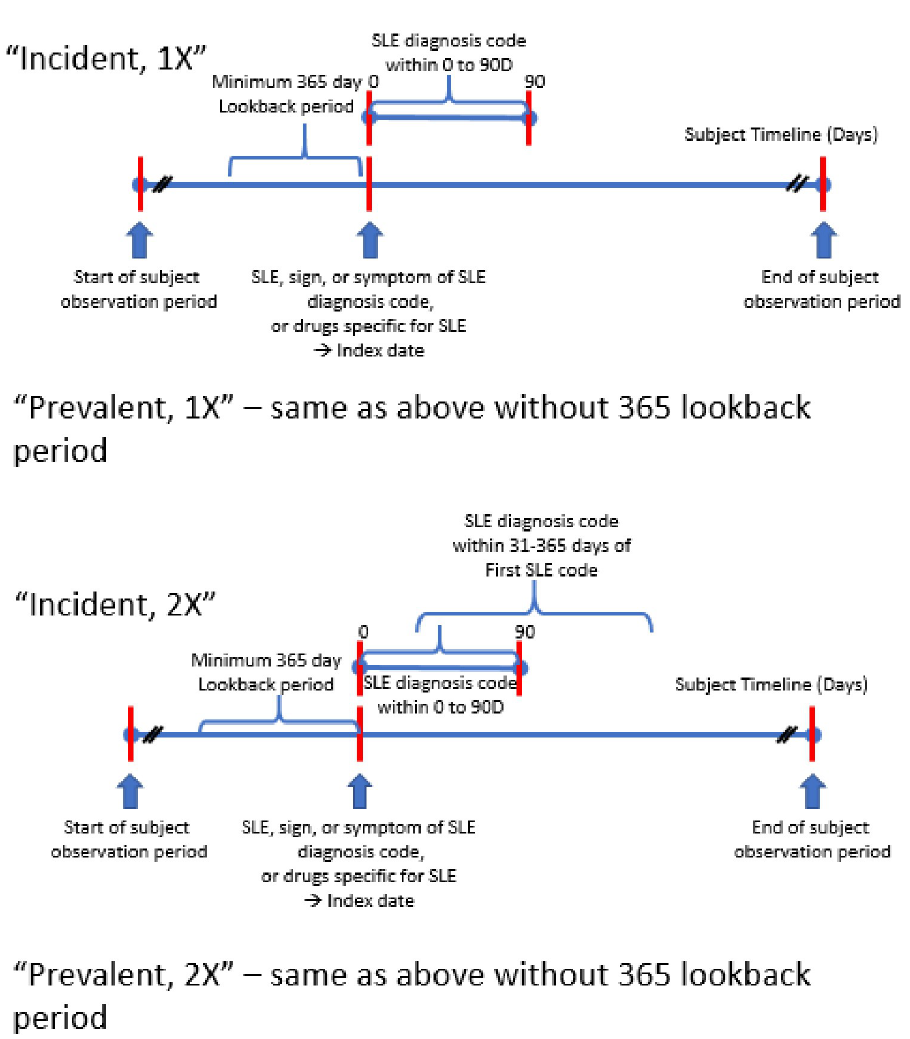
Fig 1. Diagram of the timeline for the phenotype algorithms for Systemic lupus